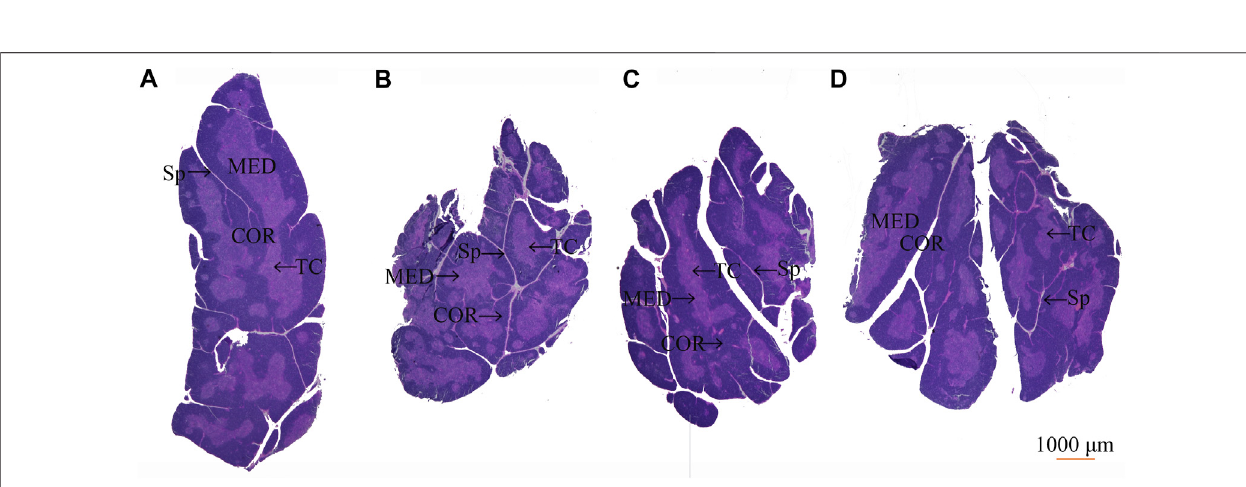
Frontiers in Pharmacology |